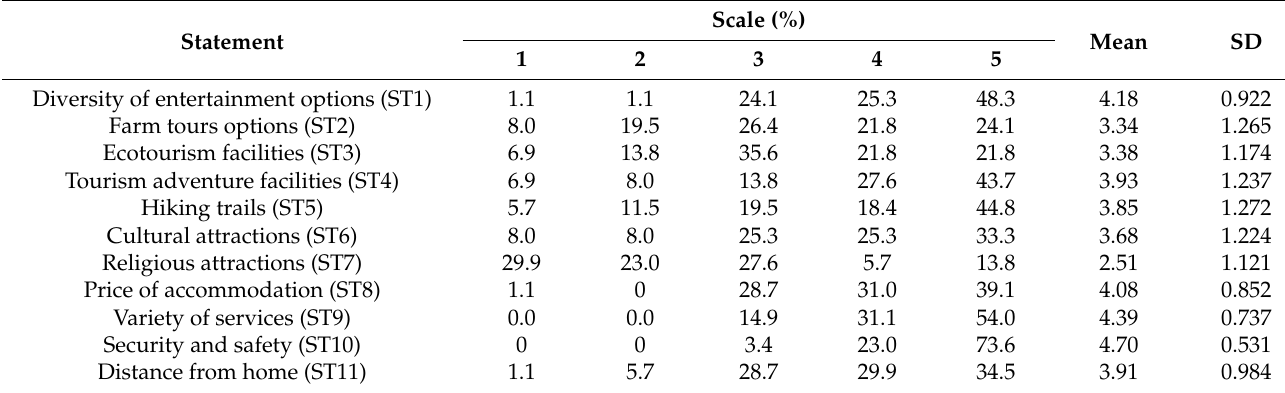
Table 4. Importance of attraction